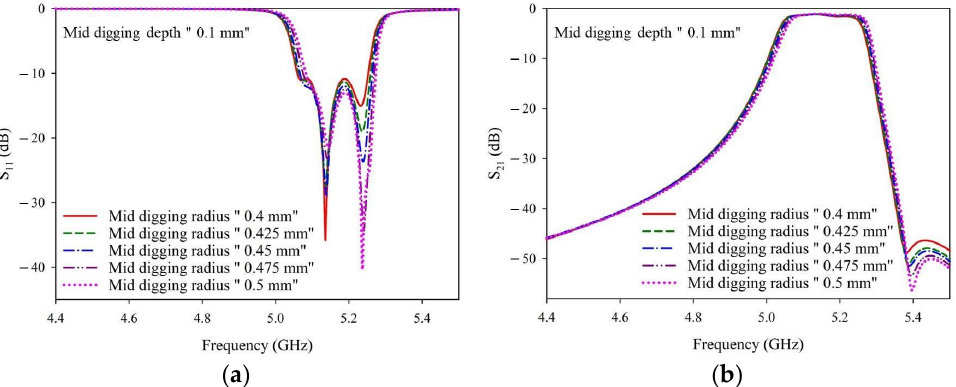
Figure 8. ( a ) S 11 and ( b ) S 21 simulation results with a fixed digging depth of 0.1 mm and various digging radii.